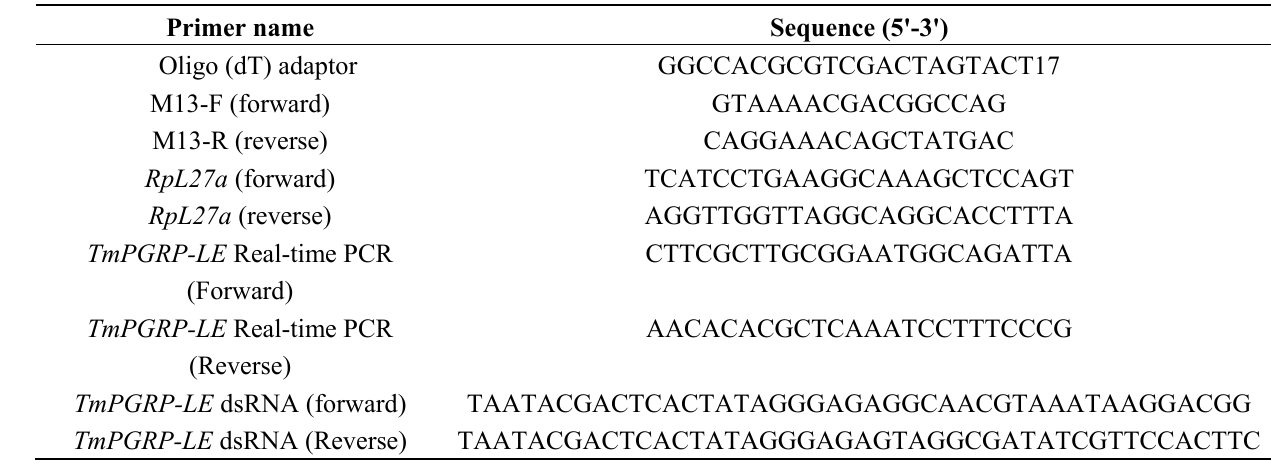
Table 1. Primers sequences used in the current